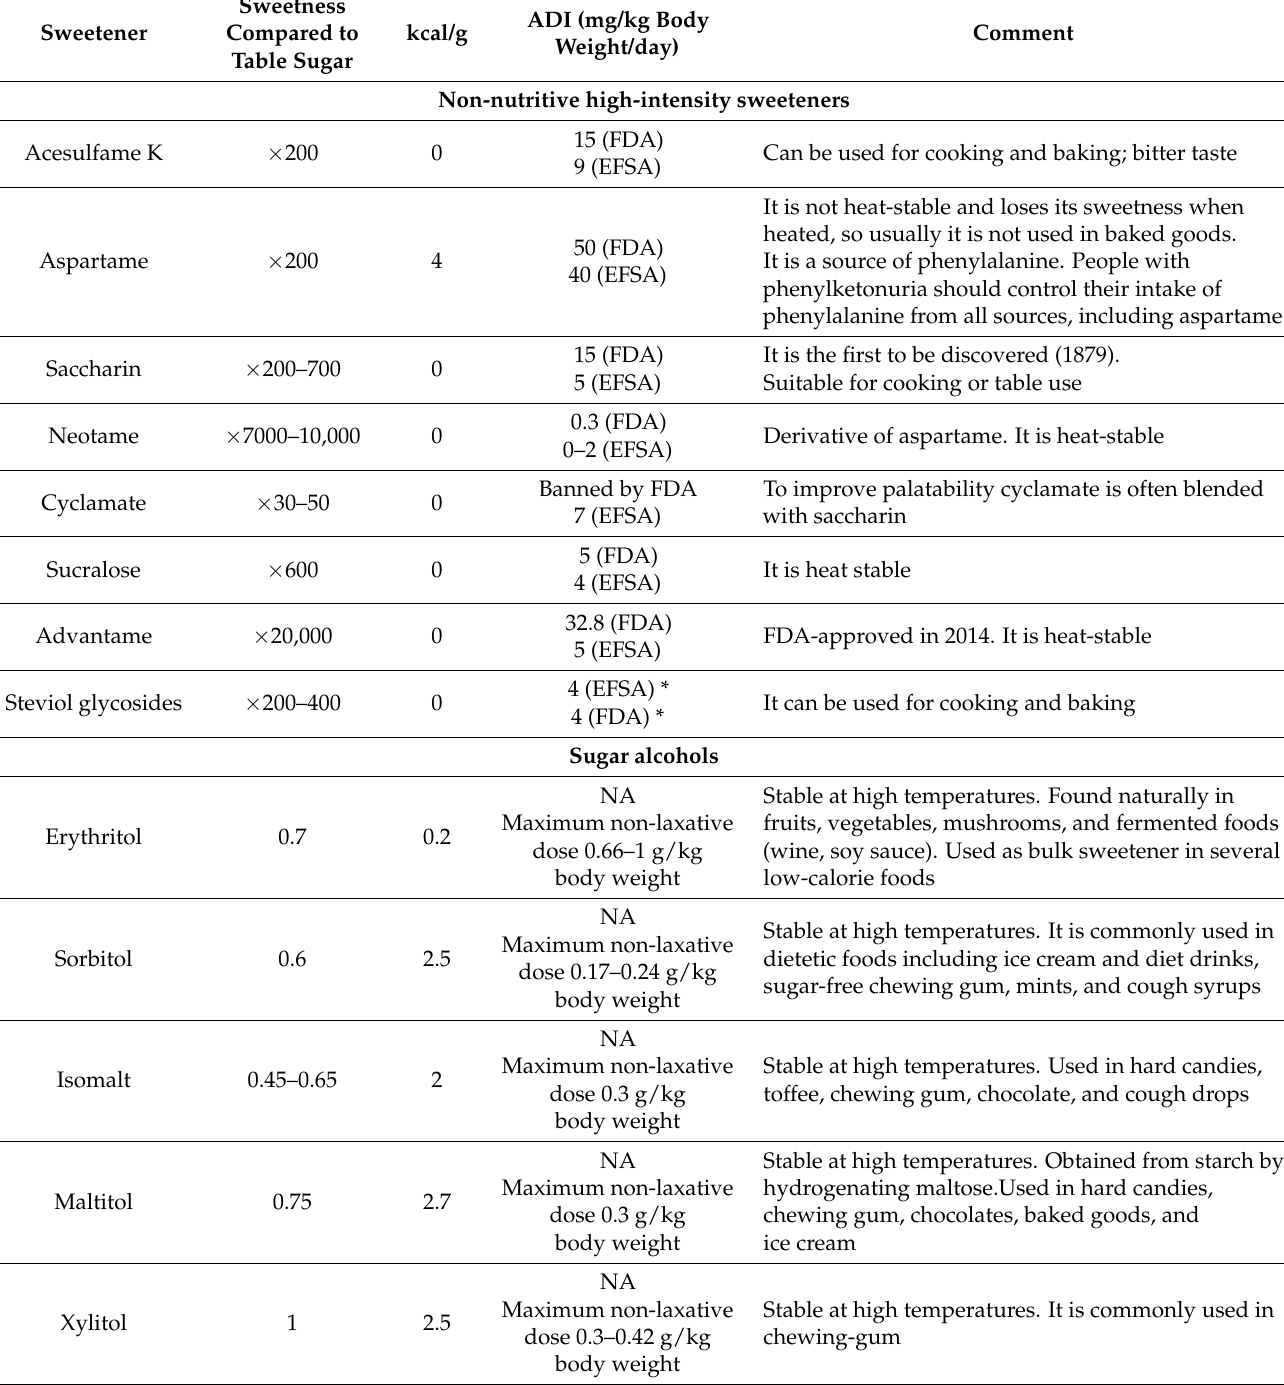
Table 2. Sweetener types and characteristics